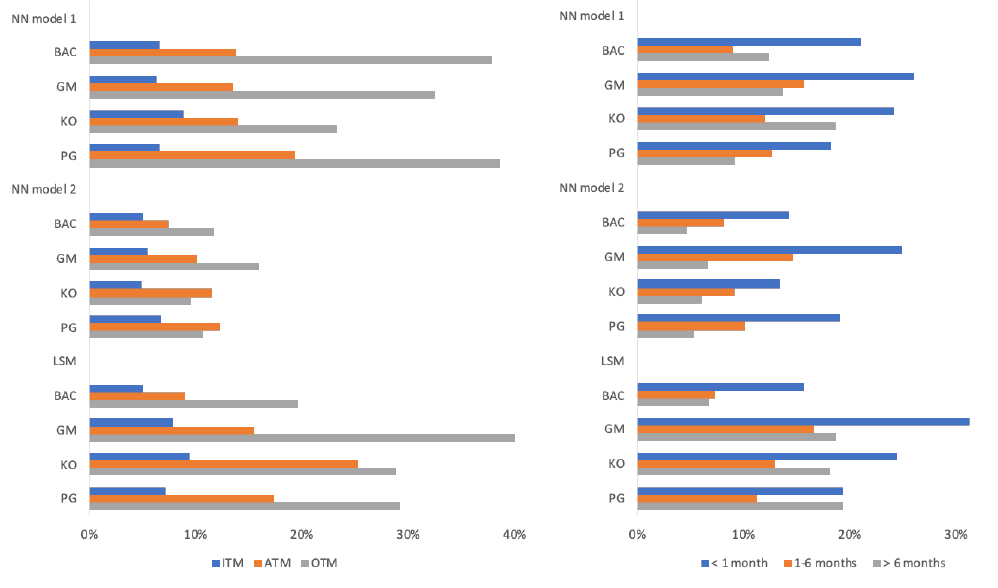
Figure 11. Relative RMSE per company: moneyness and